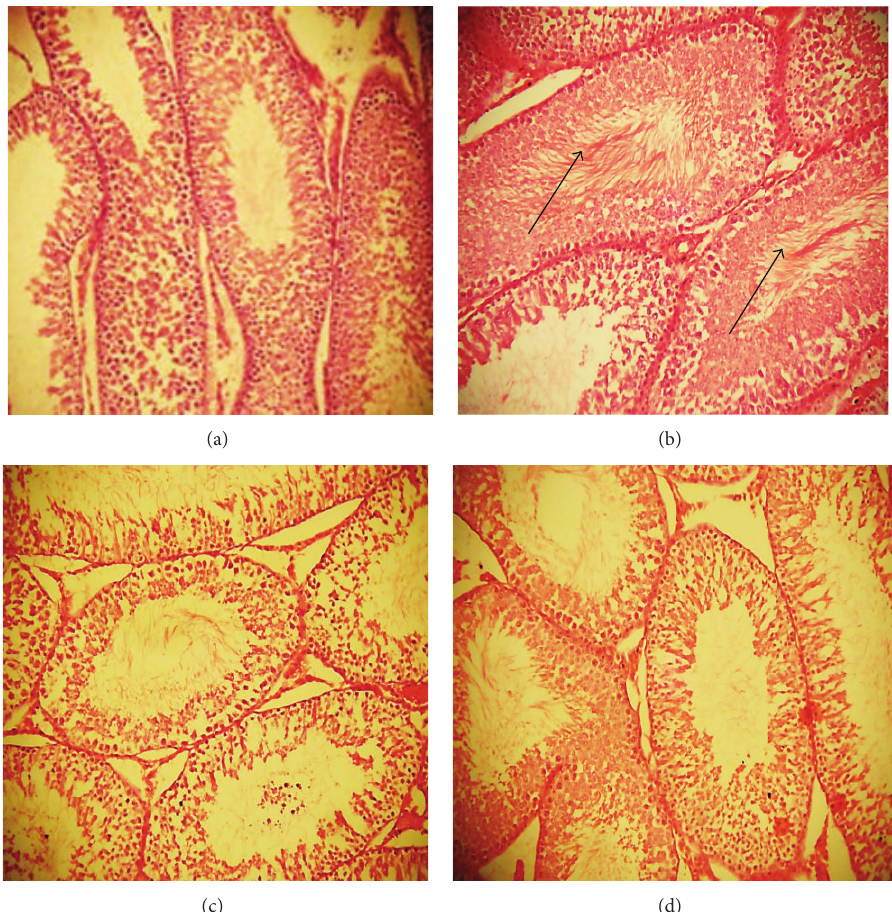
Figure 4: Photomicrograph showing protective role of kolaviron and L-ascorbic acid on chlorambucil-induced damage on testicular morphology (hematoxylin and eosin stain). (a) Control: no visible lesions seen. (b) Chlorambucil group: there are immature germinal cells in the lumen. (c) Chlorambucil + kolaviron group: no visible lesions seen; (d) chlorambucil + ascorbic acid group: no visible lesions seen.